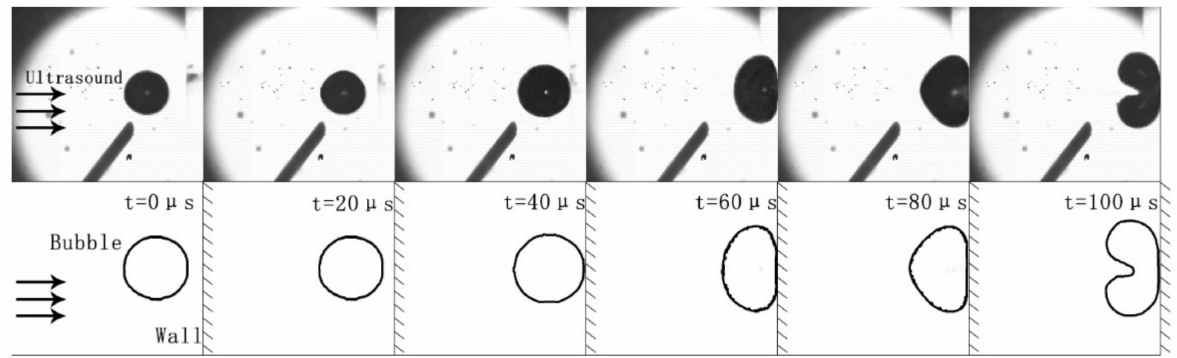
Figure 7. Ultrasonic cavitation collapse process of a single